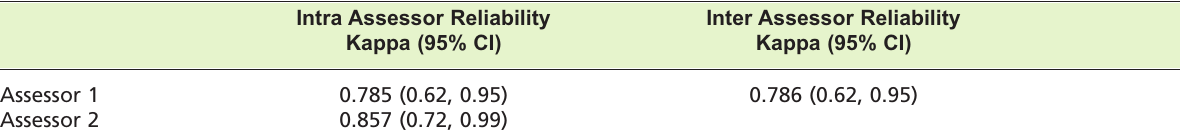
Intra and inter assessors reliability of the nerve root sedimentation sign (n= 56) Table IV: